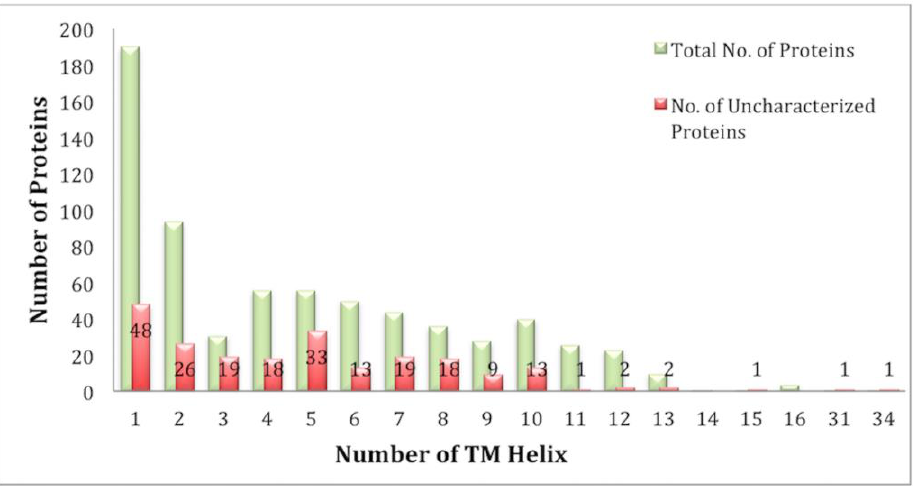
Figure 2. Overviews of the number of TM proteins having single or multiple TM helices. Red bars represent the share of uncharacterized proteins.